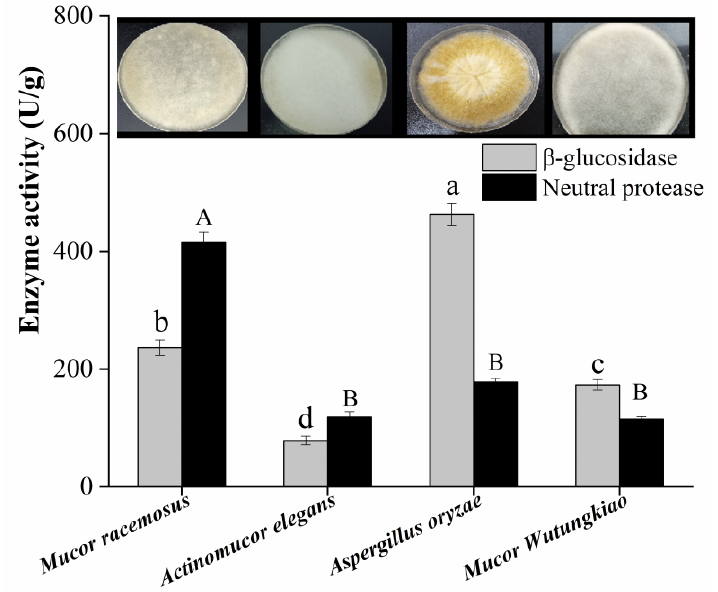
Figure 1. The activities of neutral protease and β -glucosidase of different strains. Values are expressed as the mean ± SD (n = 3). Bars with different uppercase or lowercase letters represent significant differences ( p < 0.05).